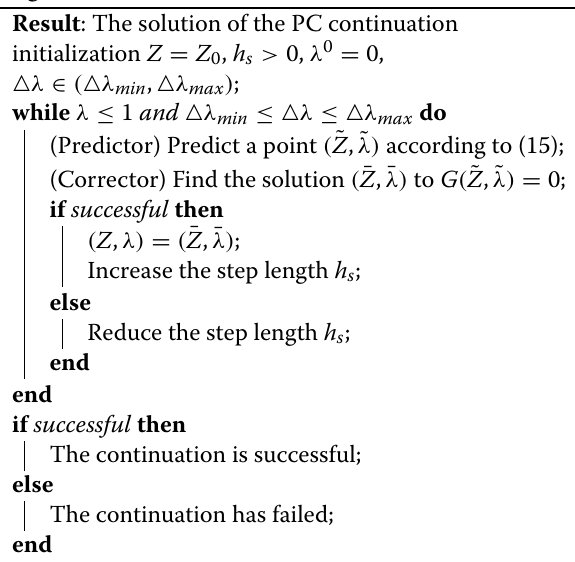
Algorithm 2: Prediction-Corrector continuation Result : The solution of the PC